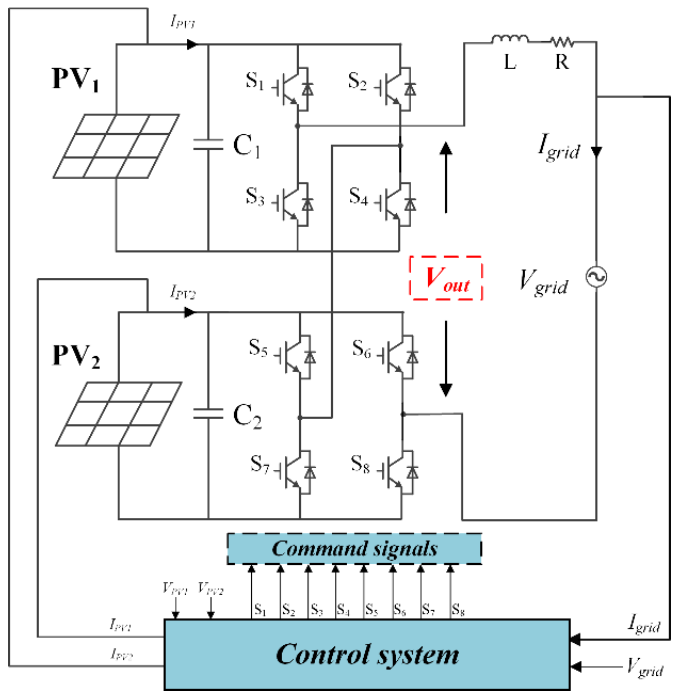
Figure 2. Cascaded photovoltaic grid-connected system topology.